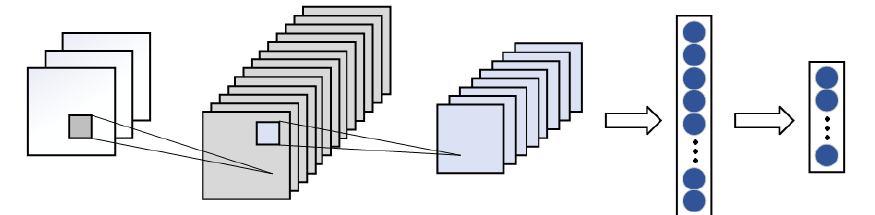
Figure 1. Basic CNN structure.